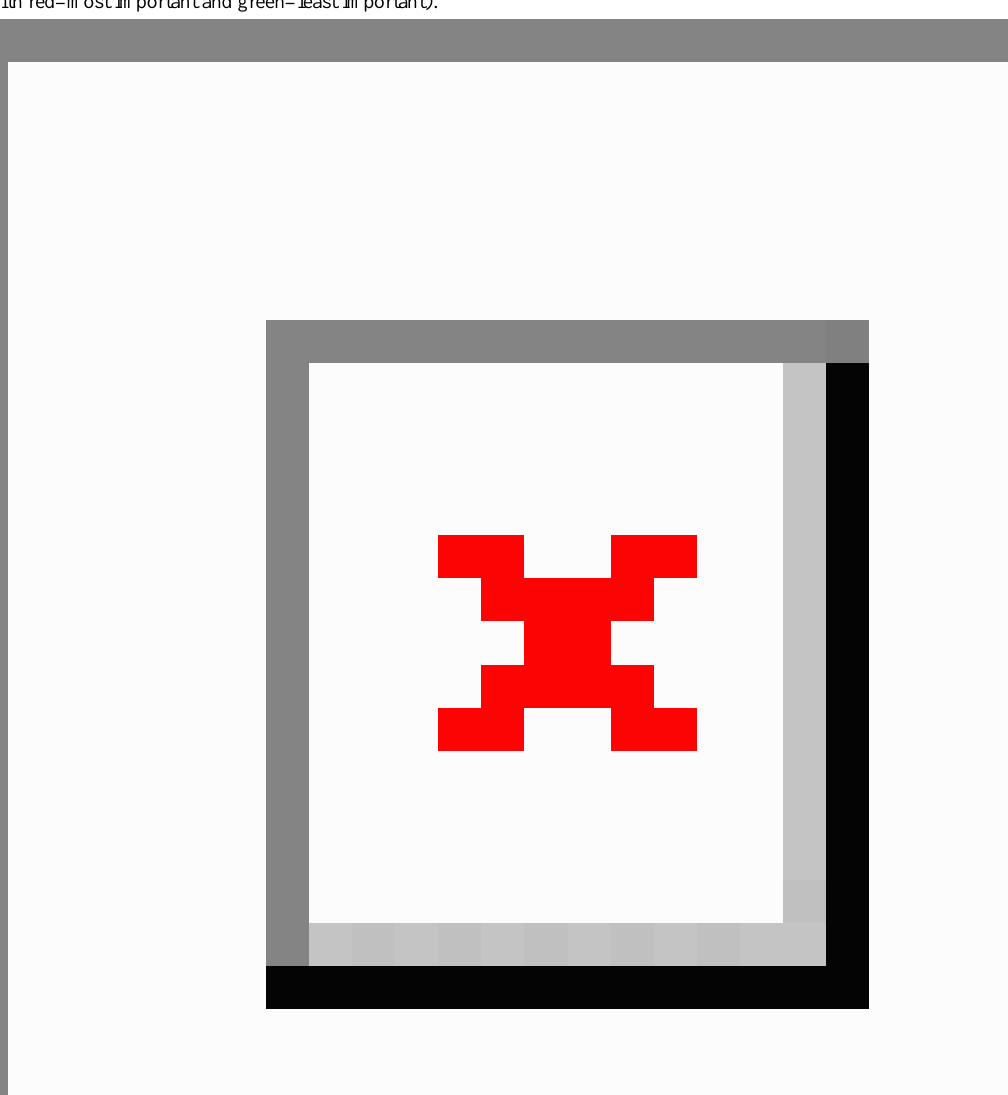
Figure 3. Assessment of “complementarity” criterion with terms detected by the expert (highlighted in yellow) and the automated system (colored boxes with red=most important and green=least